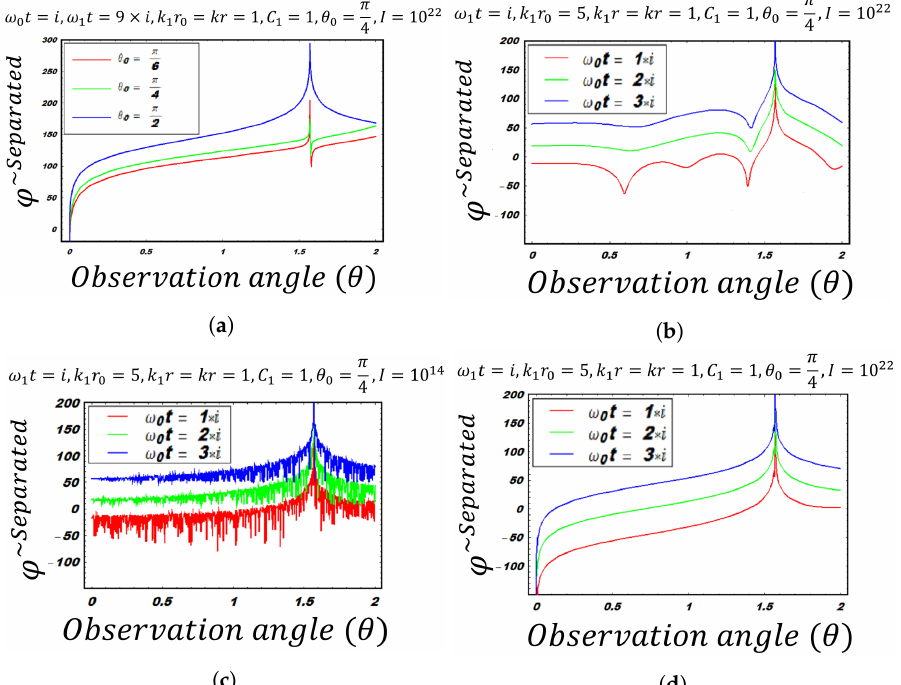
Figure 3. ( a ) Variation of the diffracted field with observation angle for different values of ( a ) incidence wave angles ( b ) oscillating strip frequency when l = 10. ( c )oscillating strip frequency for l = 10 14 . ( d ) oscillating strip frequency when l = 10 22